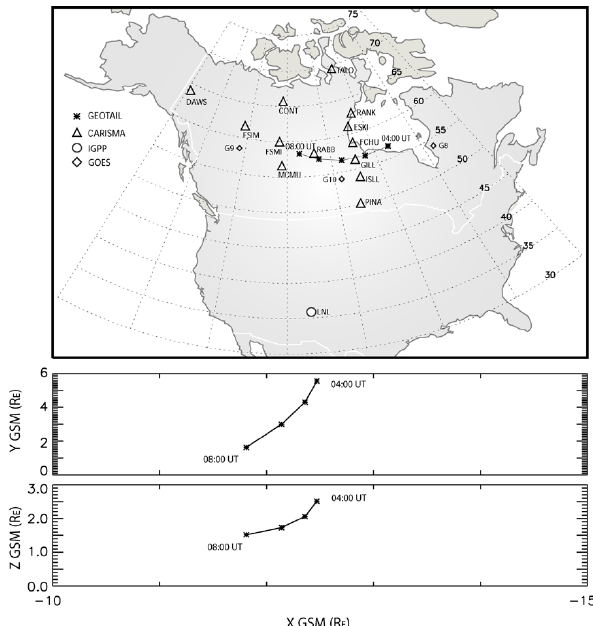
Fig. 1. (a) Ground northern magnetic field trace of the conjunction between the Geotail spacecraft and CARISMA magnetometer array between 04:00 and 08:00UT on 31 May 1998. The north magnetic footprints of GOES-8, GOES-9 and GOES-10 are also shown. The GSM location of Geotail in the x-y plane and x-z planes are plotted in panels (b) and (c) , respectively.